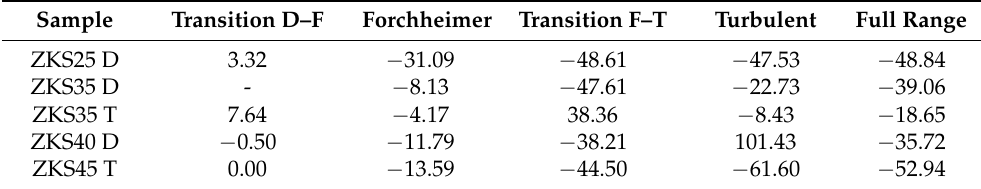
Table 2. Percentage of change of ESR foams between the permeability fitted with Forchheimer equation and that fitted with full cubic